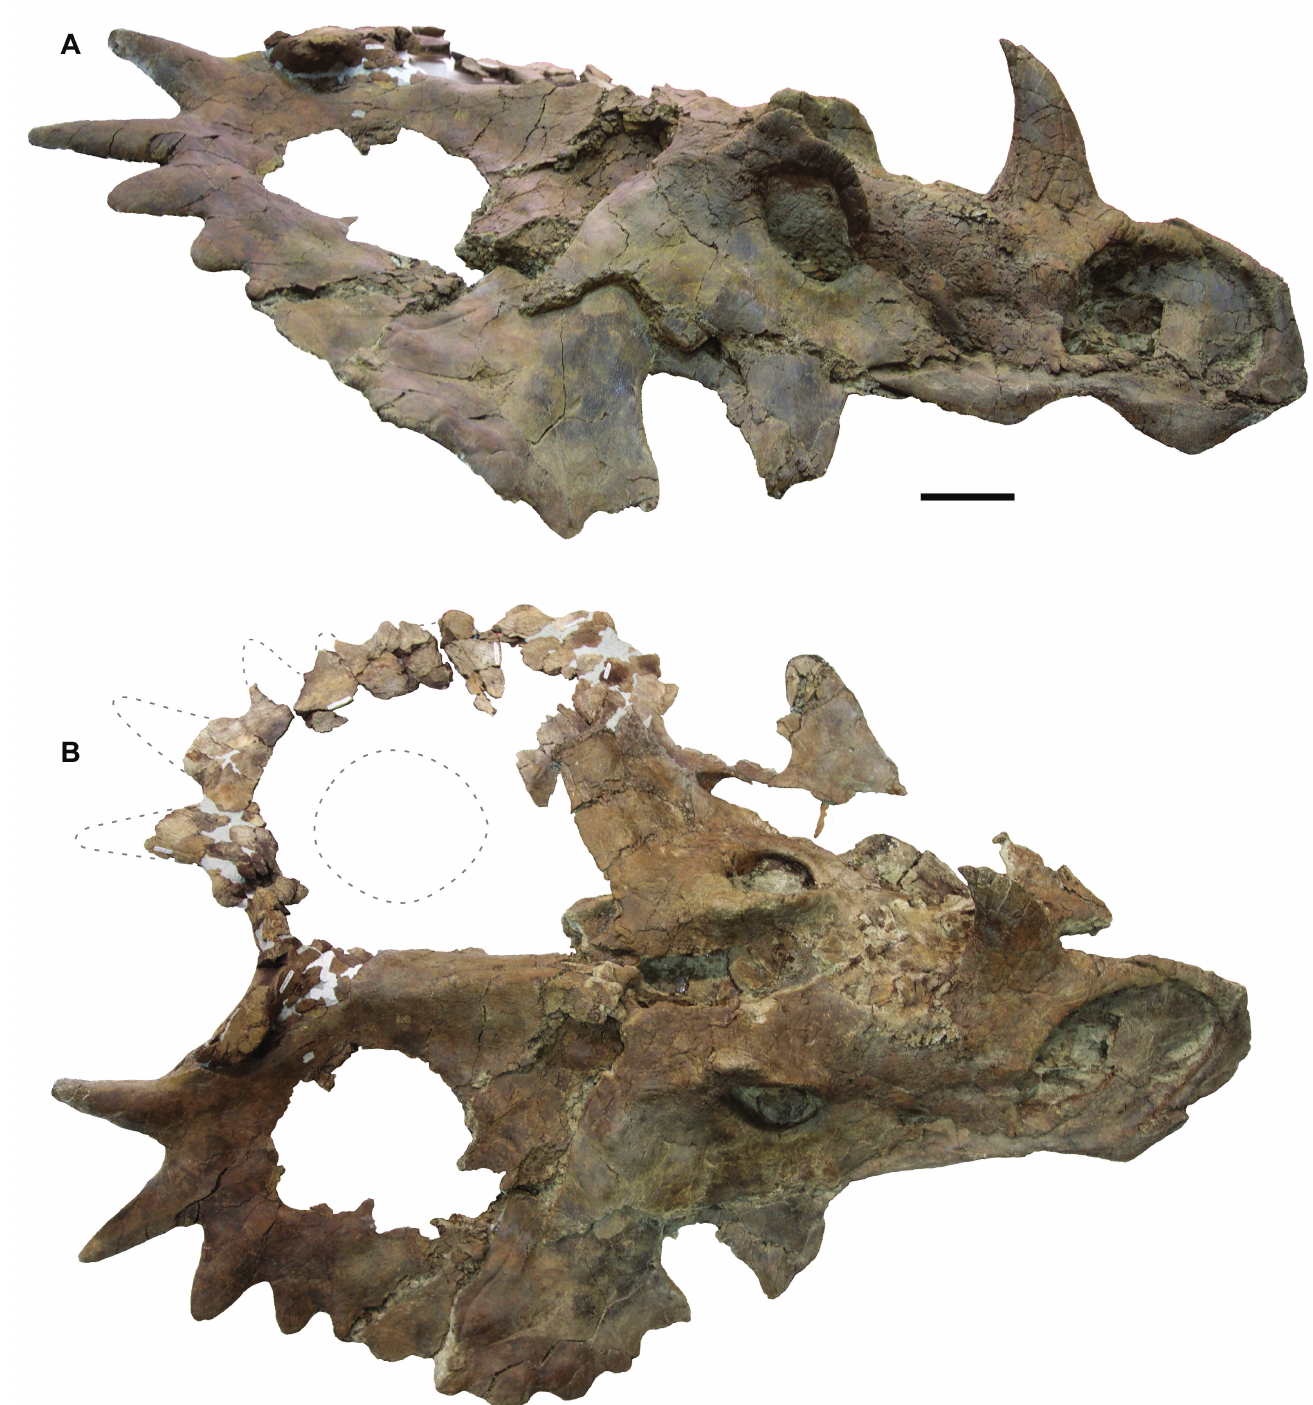
Figure 3 . Right lateral (A) and dorsal (B) photographs of TMP 2009.080.0001, a subadult skull of the centrosaurine ceratopsid Styracosaurus albertensis . Dashed lines represent approximate extent of the left side of parietal. Scale bar = 10